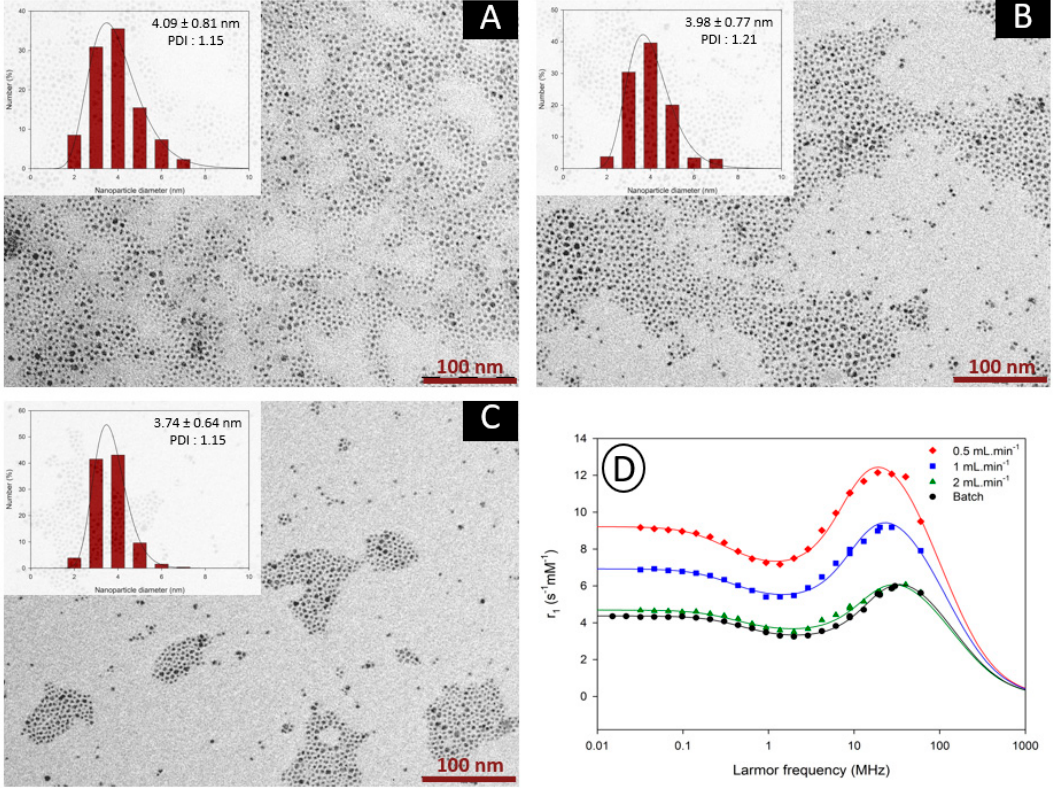
Figure 10. TEM images of the nanoparticles obtained through flow synthesis with flow rates of 0.5 mL · min − 1 ( A ), 1 mL · min − 1 ( B ) and 2 mL · min − 1 ( C ) in the 2.4 mm capillary reactor. The scale bar corresponds to 100 nm. Insets show the size distributions determined by statistical analysis; ( D ) 1 H NMRD profiles of the three samples (colored curves) and the batch-prepared sample (black curve). The continuous lines correspond to the fitting by the superparamagnetic relaxation theory.